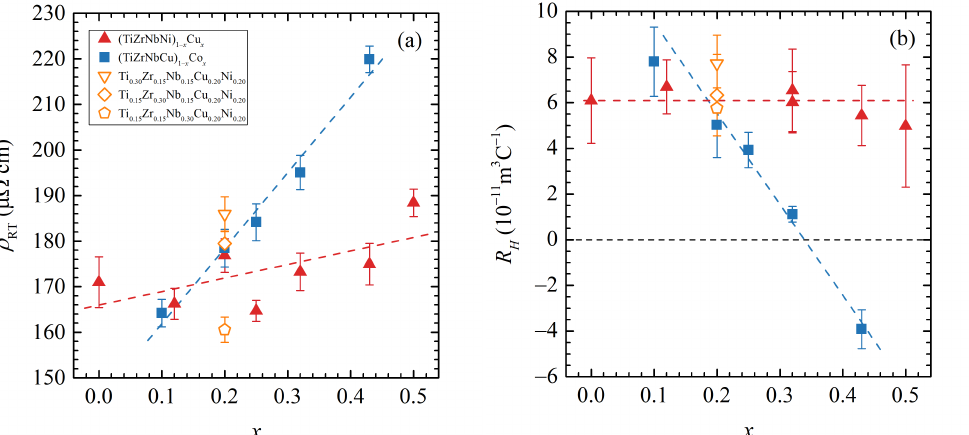
Figure 1. The composition x dependence of the room temperature resistivity ρ RT ( a ) and Hall constant R H ( b ) for ( TiZrNbNi ) 1 − x Cu x (red triangles), ( TiZrNbCu ) 1 − x Co x (blue squares) and three additional alloys with fixed (CuNi) content (open triangles, diamonds and pentagons). The dashed lines are guides to the